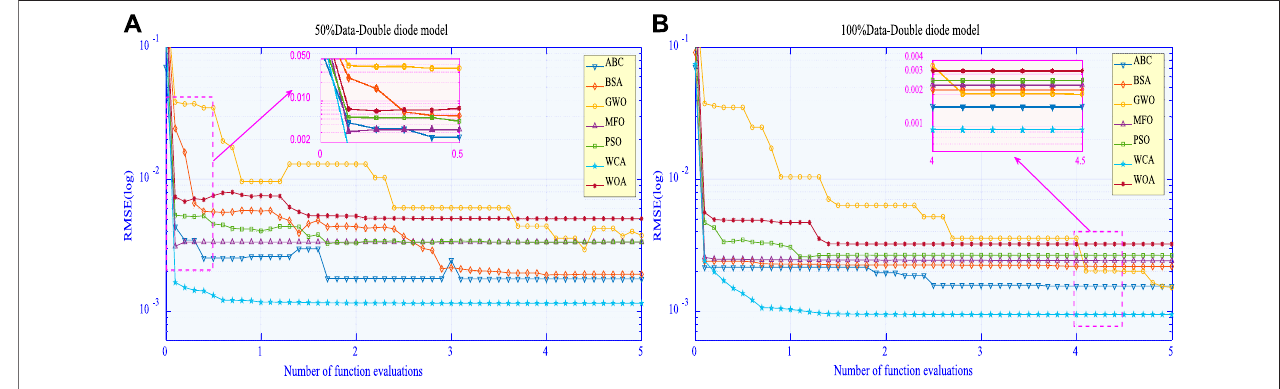
FIGURE 6 | Convergence of various algorithms for SDM: (A) 50% data and (B) 100% data.